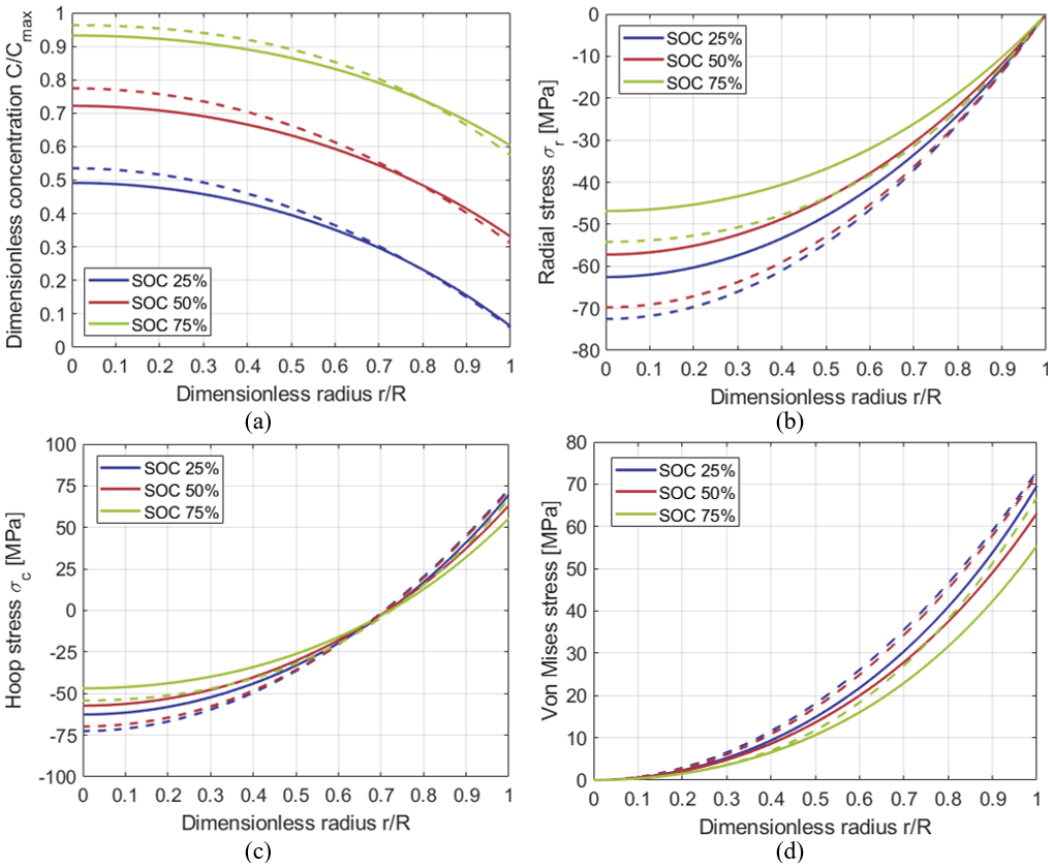
Figure 7. Lithium concentration ( a ), radial stress ( b ), hoop stress ( c ) and Von Mises stress ( d ) for different SOC levels in galvanostatic extraction in cathode cathode. Dashed lines refer to the uncoupled model and solid lines refer to the coupled model.